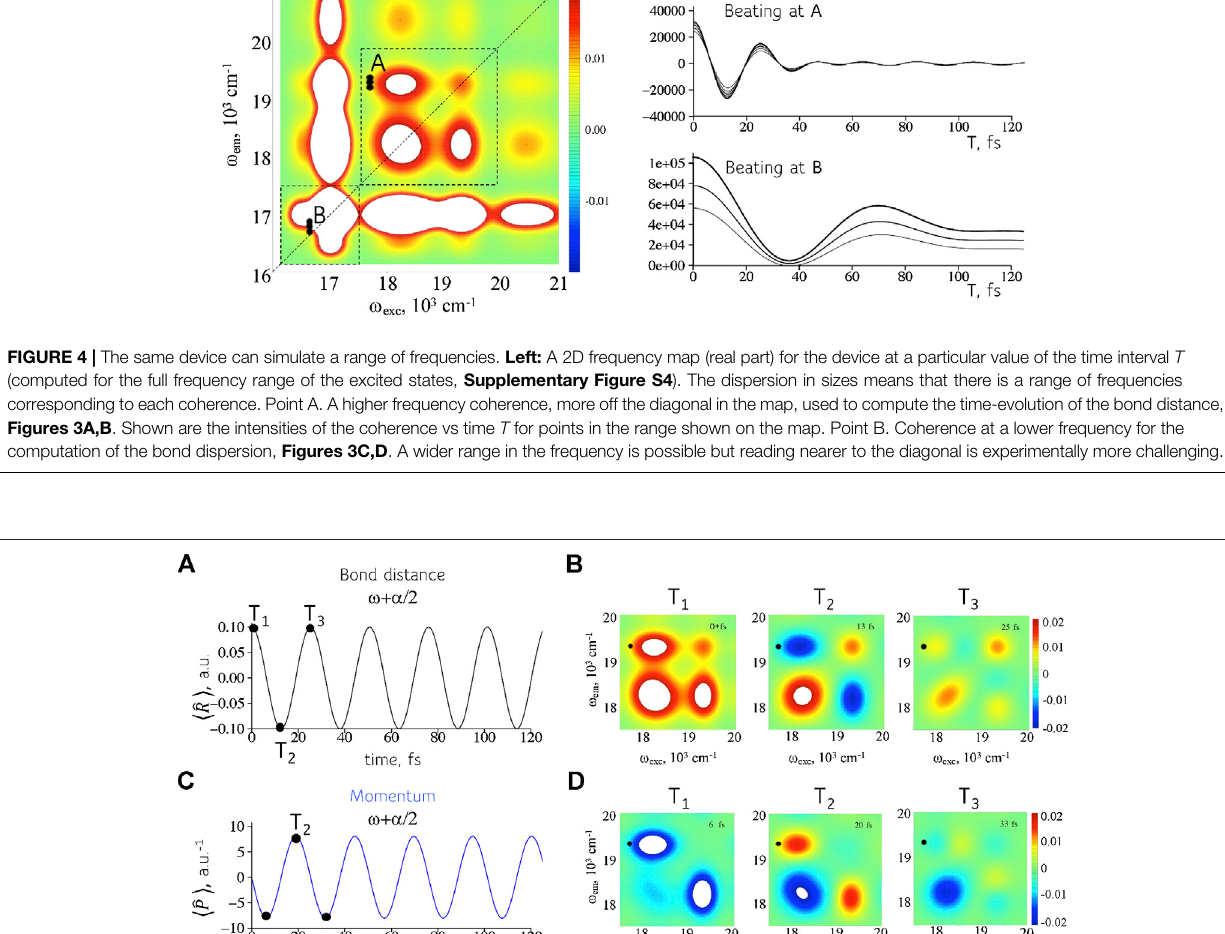
Frontiers in Physics |